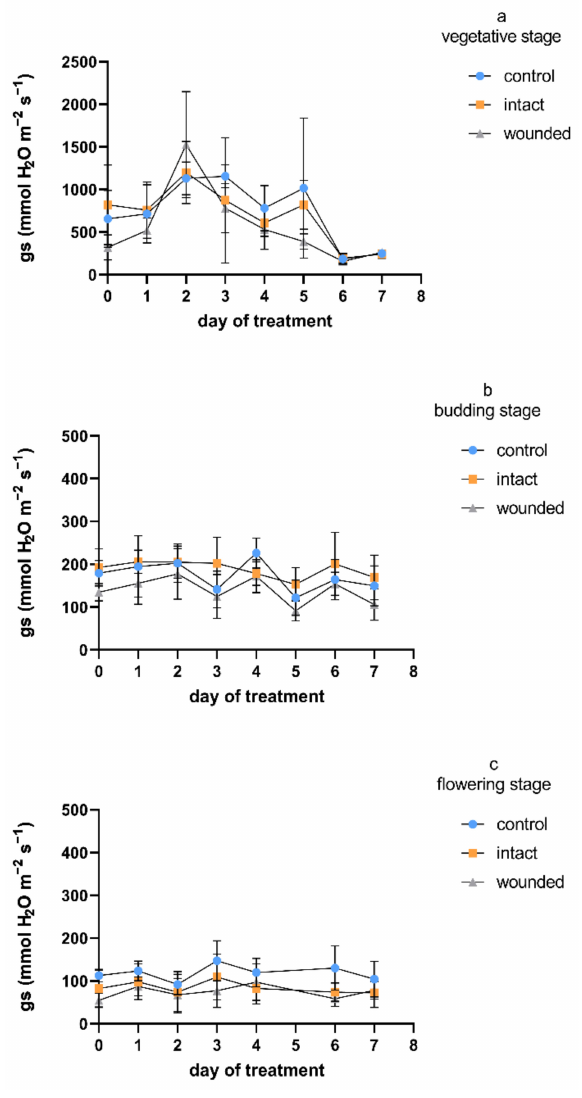
Figure 4. Stomatal conductance of Ocimum basilicum var. minimum L. versus leaf wounding im- posed at the ( a ) vegetative, ( b ) budding, or ( c ) flowering stage. Data are means ( n = 7) ± standard deviation